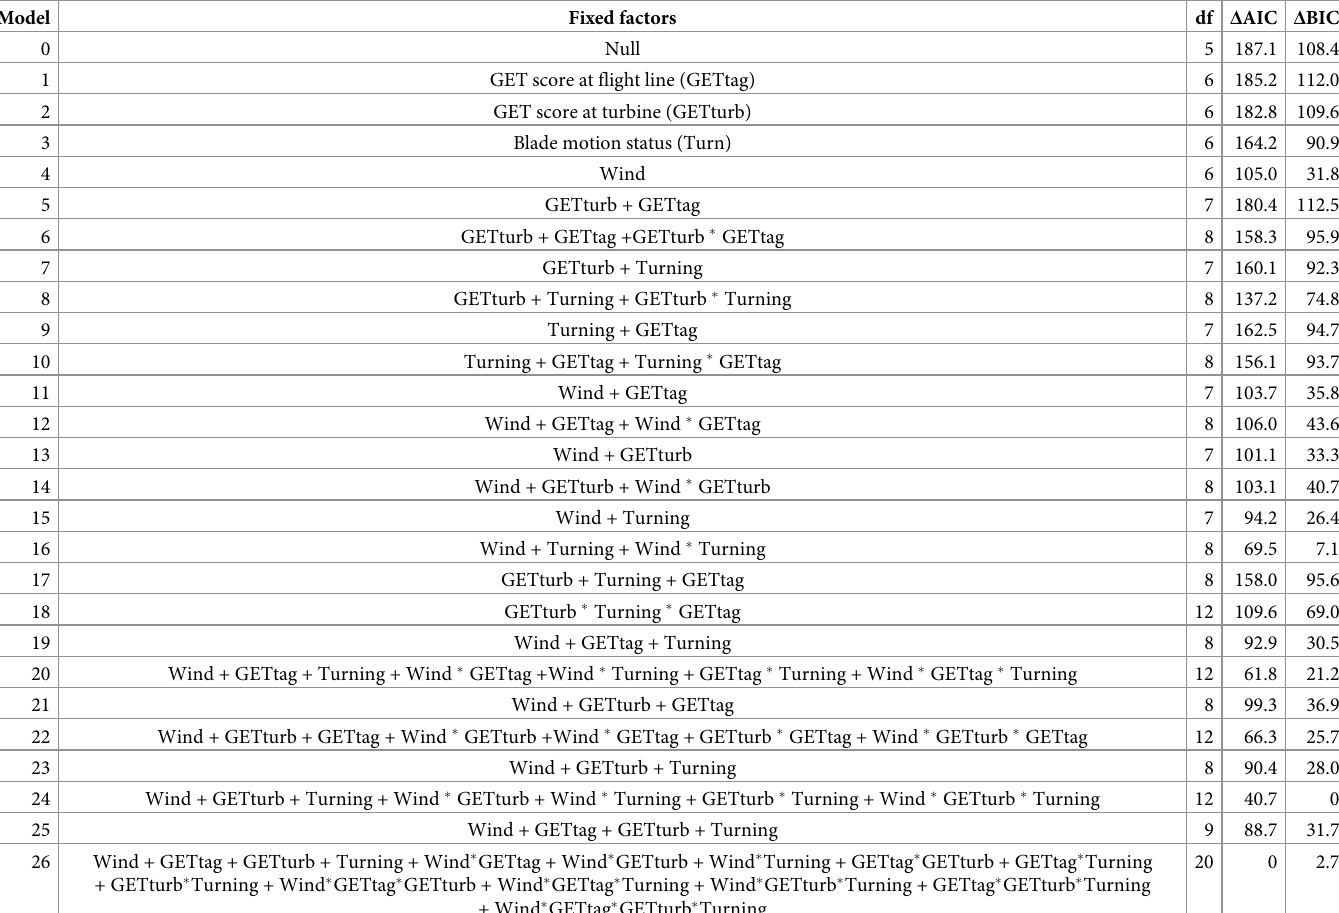
Table 3. The twenty seven model candidates in after-operation GLMMs with resultant model selection values of Δ AIC and Δ BIC.